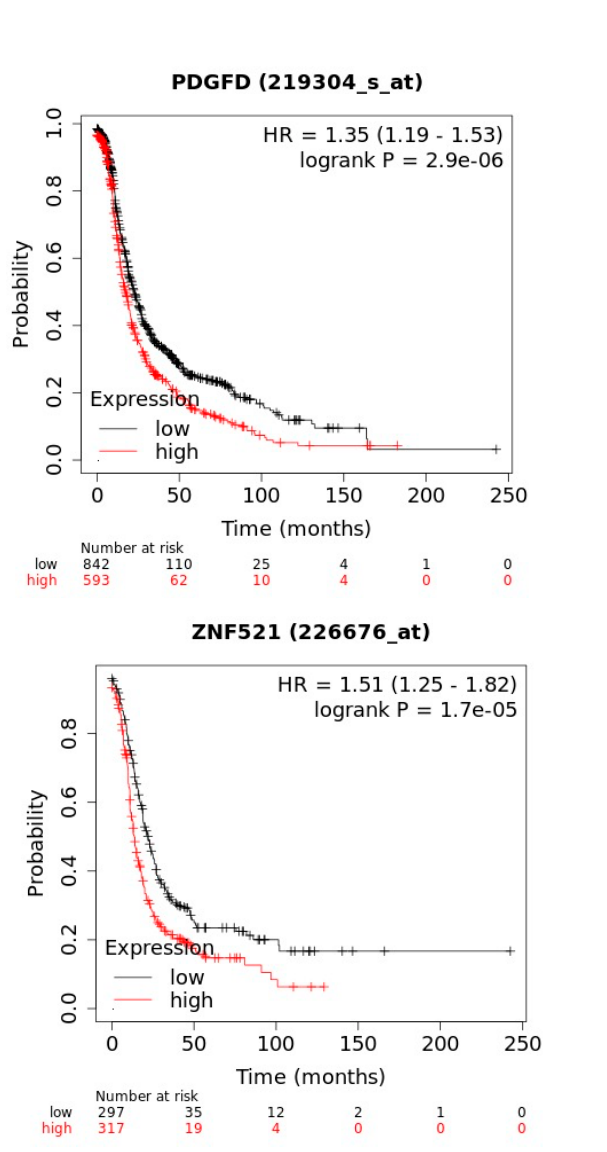
Figure 8. Survival analysis for PDGFD and ZNF521: The OS and PFS are lower for ovarian cancer patients with higher levels of these transcripts when compared with ovarian cancer patients with lower levels of these transcripts. However, this tendency does not correlate with our RNAseq results, because the two genes were reduced following RBPMS knockout, and, therefore, we expected an opposite tendency in the KM plotter.